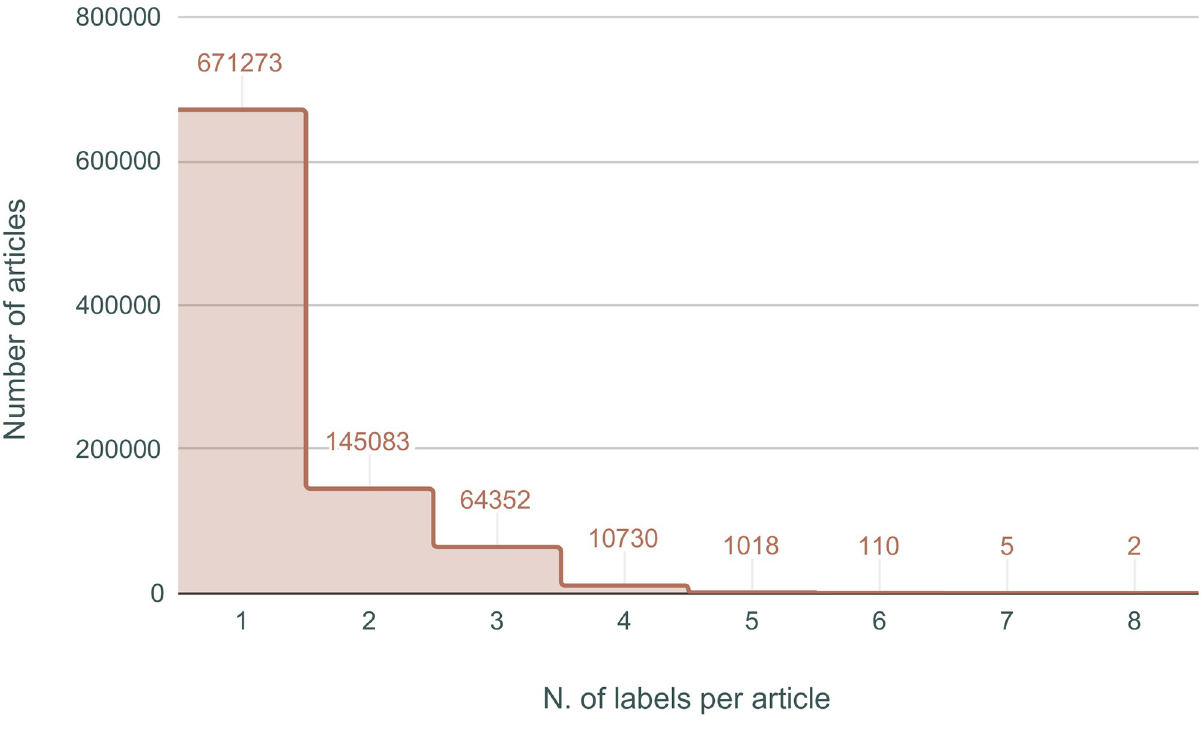
Fig 3. Distribution of the number of labels in ItWiki-100.